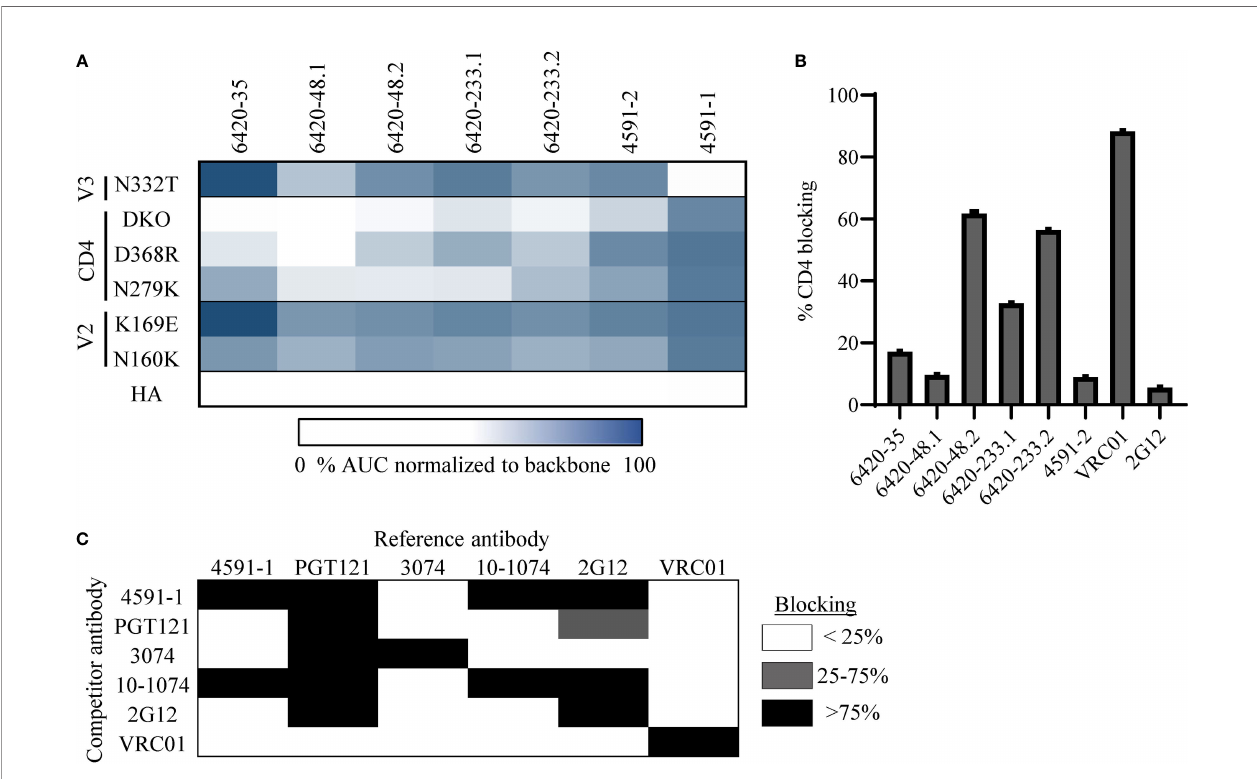
FIGURE 2 | Validation and characterization of CD4bs and V3-glycan speci fi c antibodies discovered through LIBRA-seq. (A) A heat map of ELISA AUC values for binding to BG505.SOSIP variant proteins are shown for each antibody. AUC values for each variant were normalized to BG505.SOSIP.backbone for each antibody. ELISA binding curves are located in the supplement. (B) HIV-1 Env/CD4 inhibition ELISA data is shown for all antibodies. CD4bs antibody VRC01 was used as a positive control and outer domain glycan speci fi c antibody 2G12 was used as a negative control. Data is shown as % CD4 blocking by each antibody. (C) Competition ELISA of 4591-1 with antibodies PGT121, 3074, 2G12, and 10-1074. Antibody VRC01 was used as a negative control. Data is shown as % inhibition of binding by the reference antibody. White indicates <25% inhibition, grey indicates 25-75% inhibition and black represents >75% inhibition. All ELISAs were performed in technical duplicate with 2 biological duplicates; data represented as mean ±